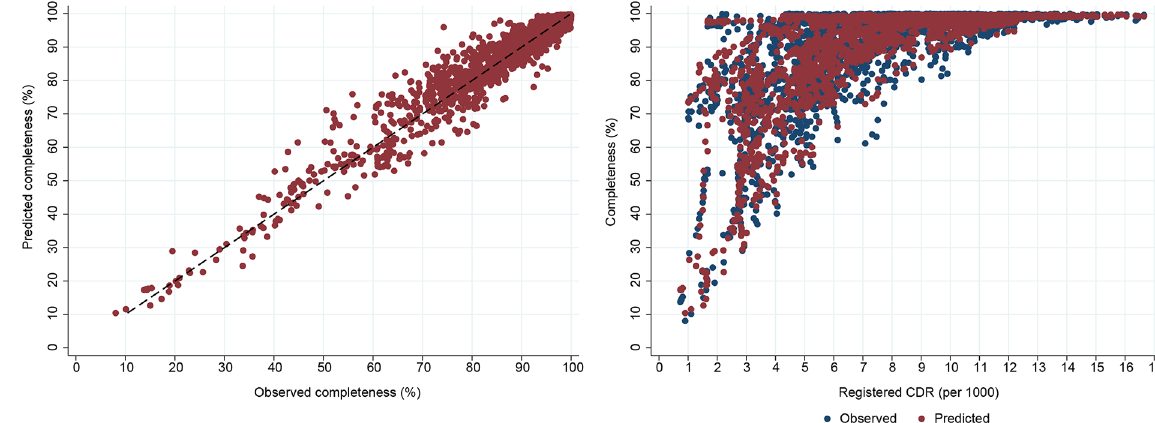
Fig 3. Predicted versus observed death registration completeness, and predicted versus observed death registration completeness by registered CDR, Model 1, both sexes.